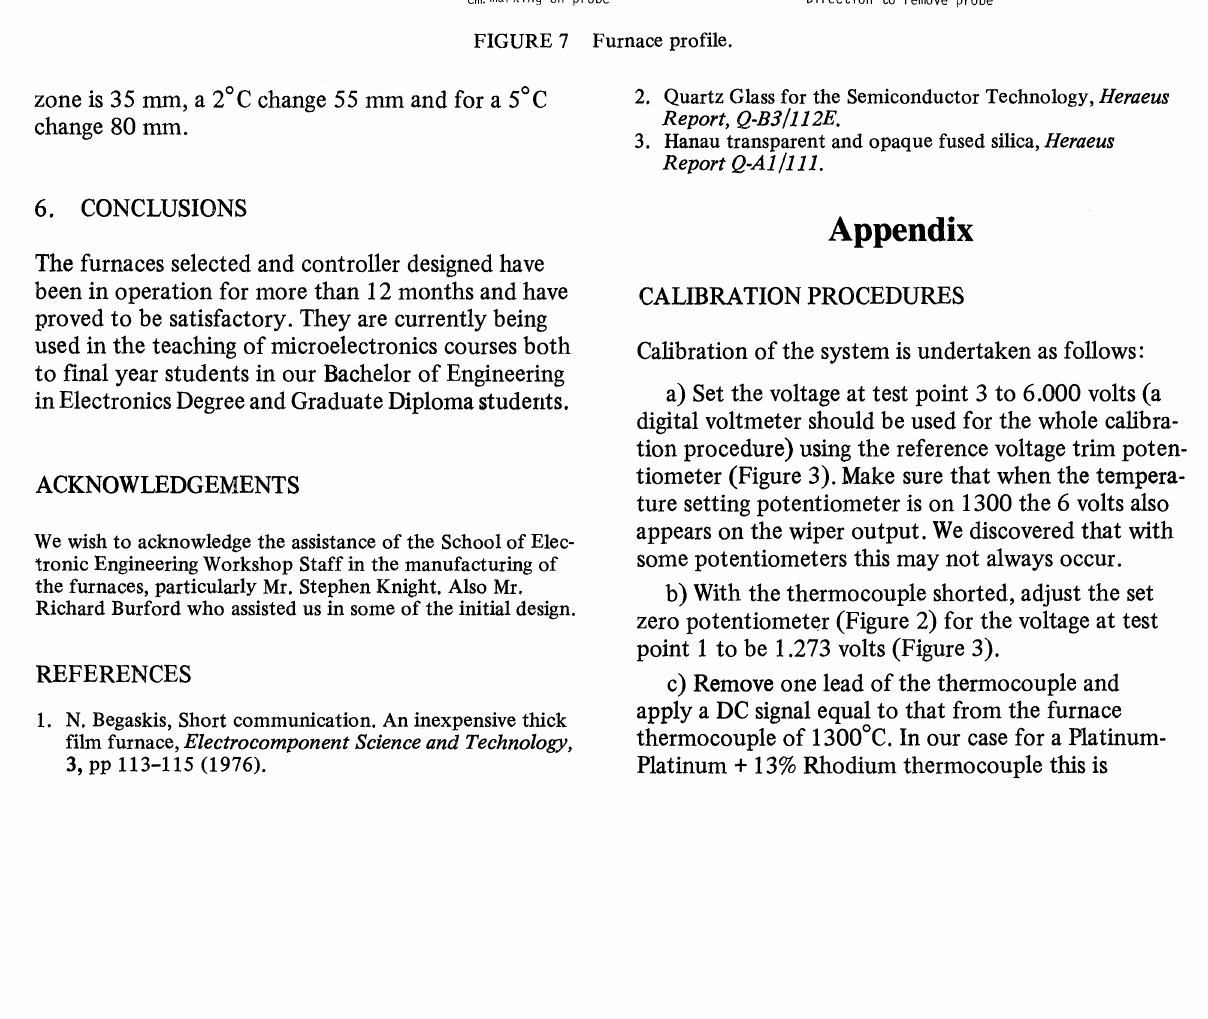
FIGURE 7 Furnace